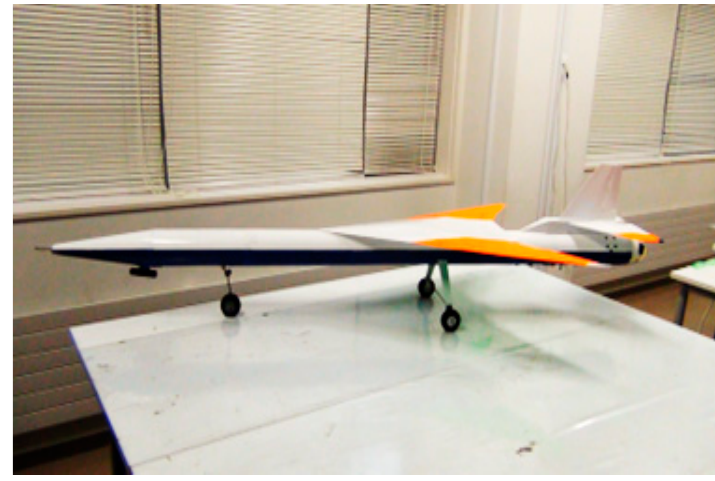
Figure 1. One-third-scale Oowashi.